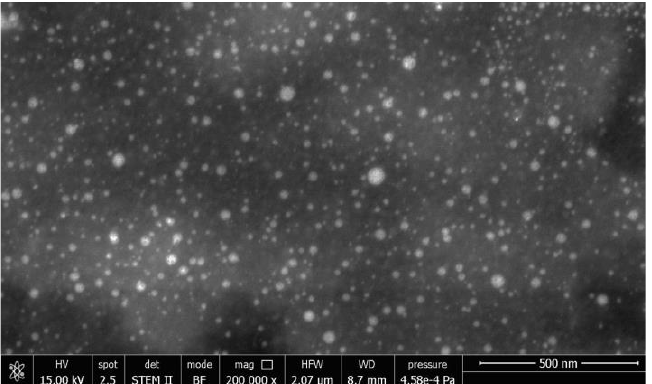
Figure 1. STEM micrography (200,000 × g magnification) of dalargin (DAL)-medicated nanoparticles (DAL-NP), as purified by centrifugation.